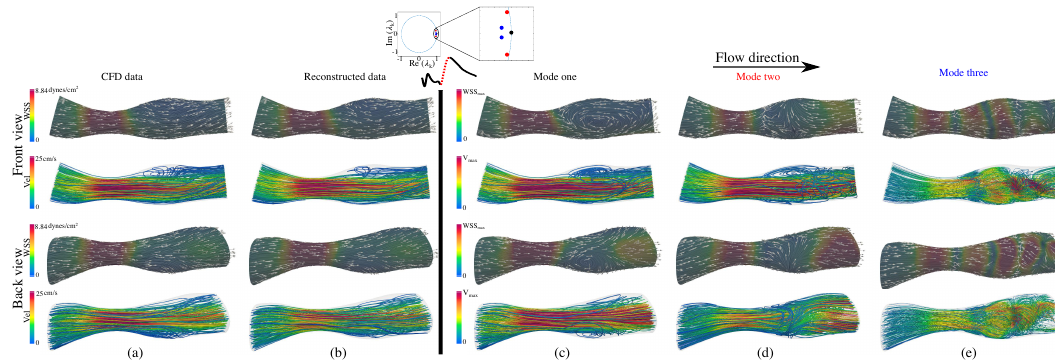
Figure 6. Velocity and WSS CFD data and the mDMDc modes are shown in the second stage of the coronary artery stenosis model. The stage is highlighted with a red dashed line in the flow waveform. The location of discrete eigenvalues in the unit circle corresponding to the selected mDMDc modes are shown. Velocity and WSS streamlines are shown and colored by their magnitude. WSS vectors are normalized and shown on top of the WSS streamlines to show the WSS vector direction. ( a ) CFD data (time = 0.36 s), ( b ) reconstructed data with 95% accuracy, ( c ) real part of the mDMDc mode corresponding to the eigenvalue λ = 1, ( d ) real part of the mDMDc mode corresponding to the eigenvalue λ = 0.98 ± 0.15 i , ( e ) real part of the mDMDc mode corresponding to the eigenvalue λ = 0.94 ± 0.03 i .